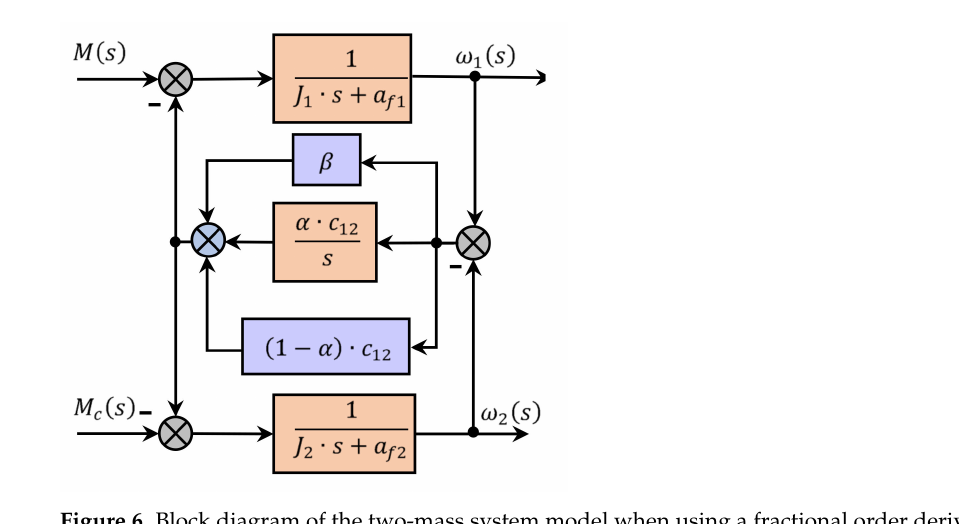
Figure 6. Block diagram of the two-mass system model when using a fractional order derivative to describe the elastic